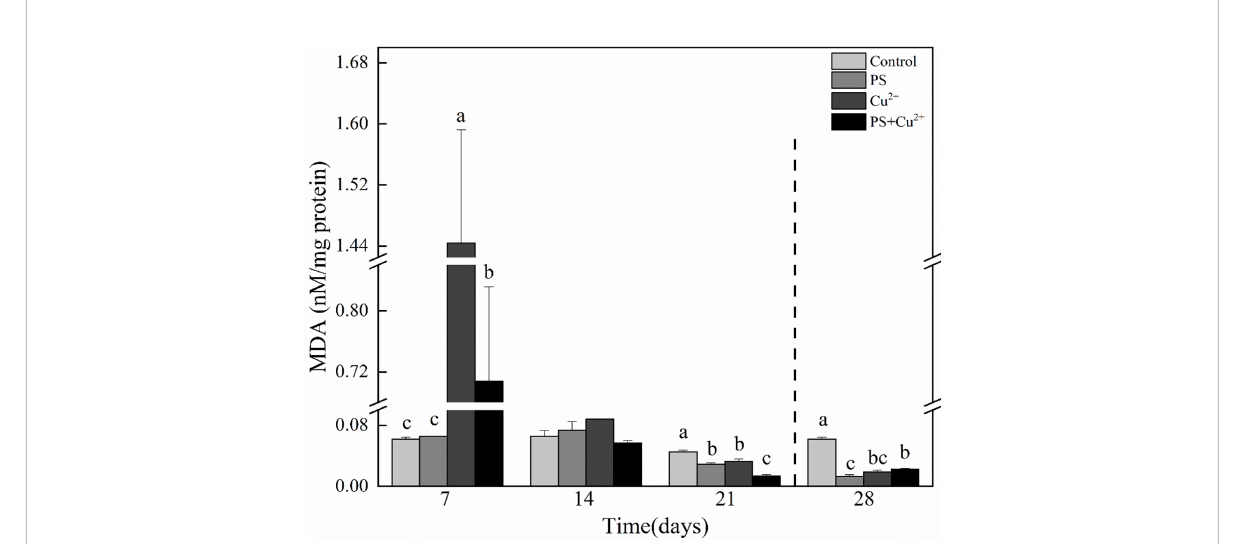
Compared with the control group on day 7, GSH levels were decreased in the nano-PS- and nano-PS+Cu 2+ -exposed groups. On days 14 and 21, all the groups having different experimental conditions showed lower GSH levels compared to the control